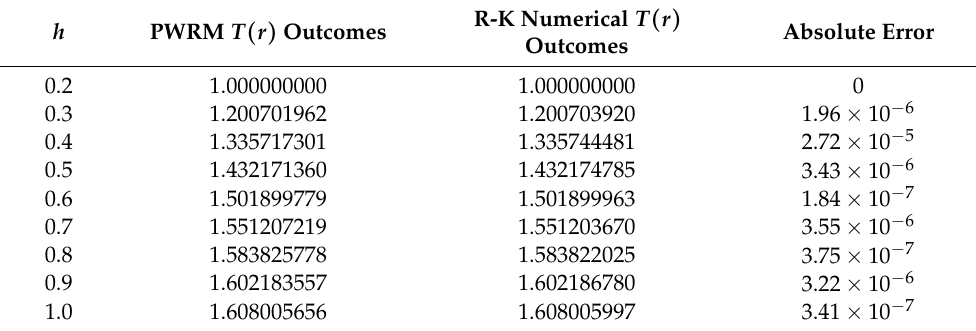
Table 2. The analytical and numerical outcomes’ validation for mixed type 1